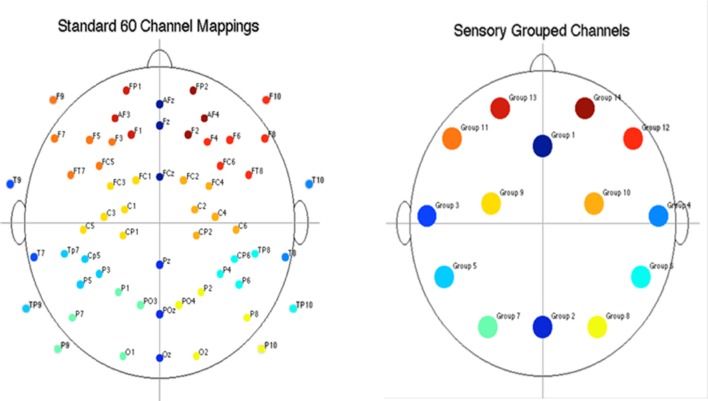
Diagram of electrode placement and channel grouping for data reduction purposes. Original 60 channels (top) and reduction to 14 channel groups (bottom).